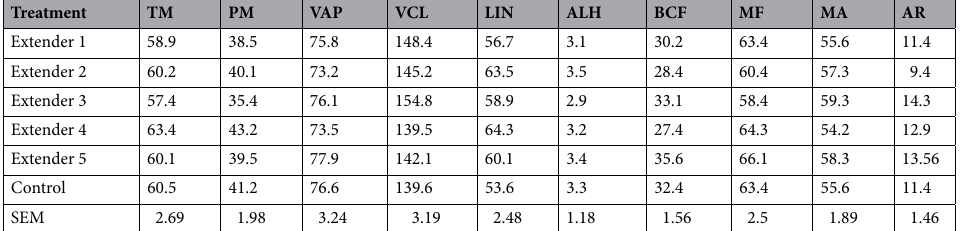
Table 3. Post-thaw motion and flow cytometry parameters of bull sperm in 5 top algorithm driven extenders. There were no significant differences between top dot and control extenders. Kinetic parameters were measured by computer assisted semen analysis (CASA). TM, total motility; PM, progressive motility; VSL, progressive velocity; VCL, curvilinear velocity; LIN, linearity; BCF, beat cross frequency; VAP, average patch velocity; ALH, amplitude of lateral head displacement. Cellular parameters were measured by flow cytometer. MF, sperm with membrane functionality; MA, sperm with mitochondria activity; AR, sperm with acrosome